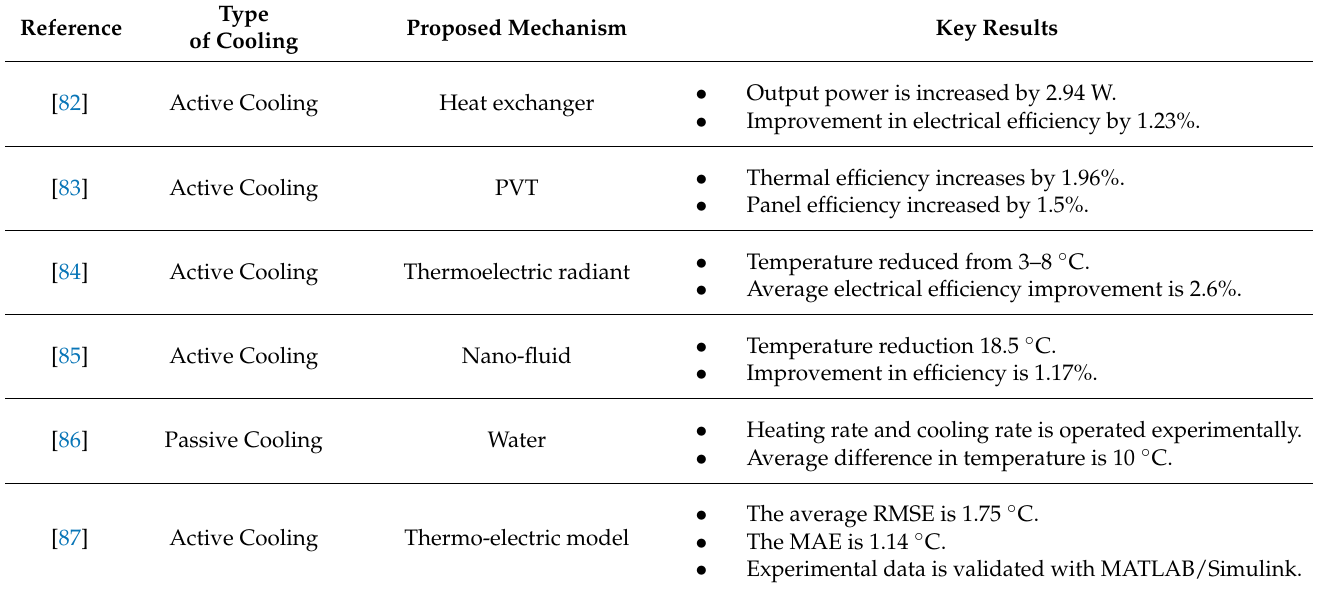
Table 3. Comparison of other published